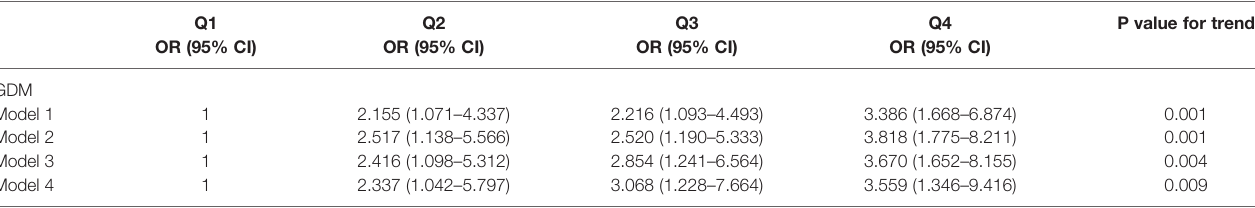
TABLE 4 | Odds ratios and 95% con fi dence interval for GDM according to quartile of serum PCSK9 levels (n = 300). Q1 Q2 Q3